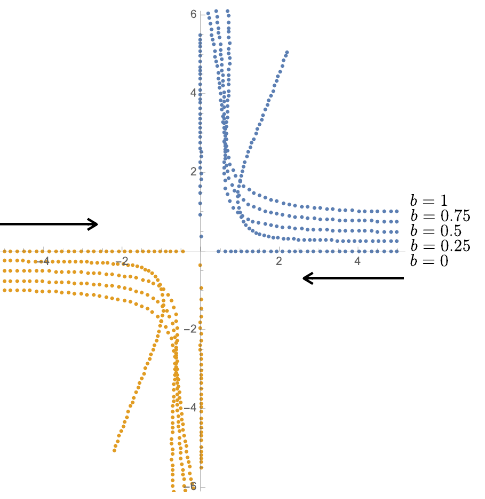
Figure 13 . Trajectories of the two initially orthogonal vortices with impact parameter b = 0 , 0 . 25 , 0 . 5 , 0 . 75 , 1